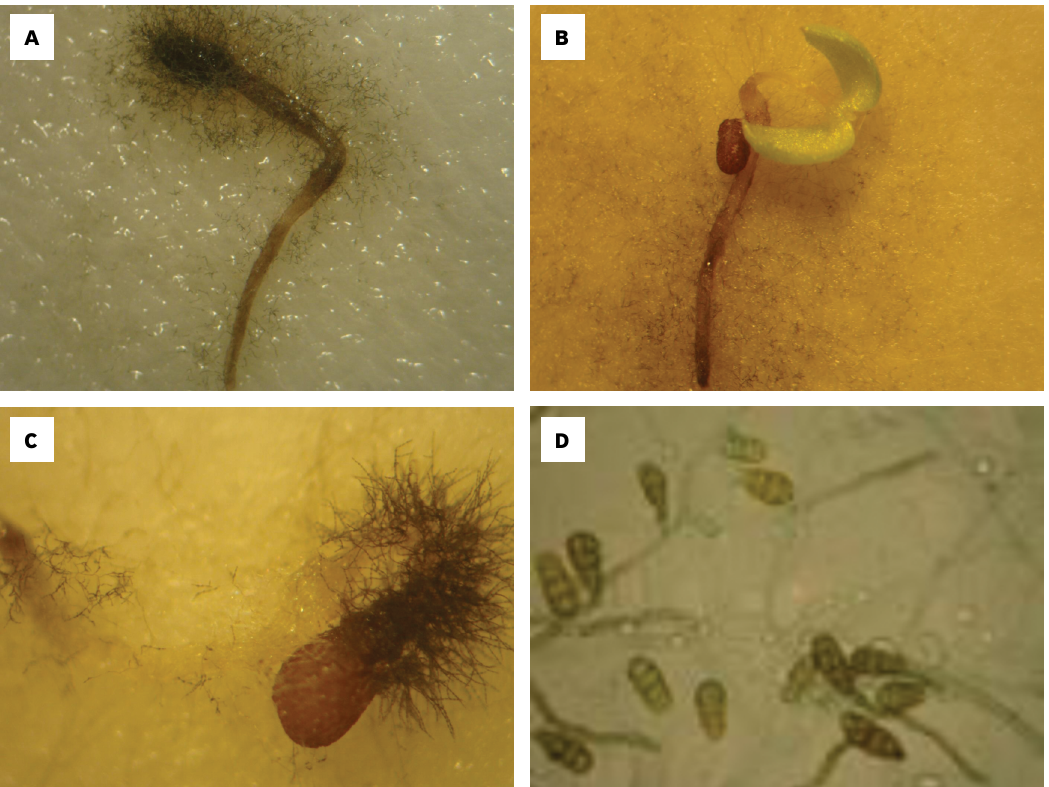
BAFigure 1. (A, B, C) Growth of Alternaria alternata in tobacco seedlings showing necrotic symptoms in the hypocotyl; (D) conidia of A. alternata .